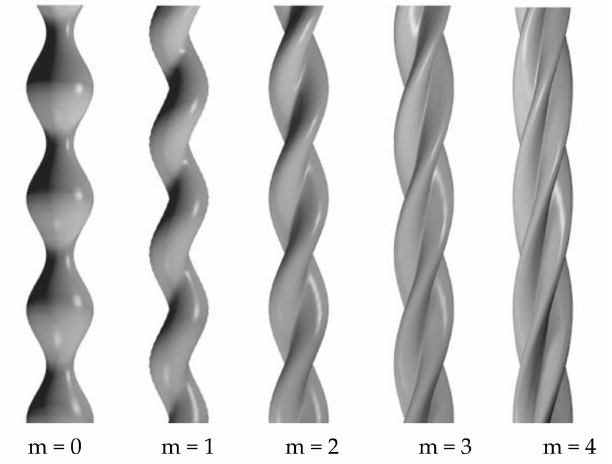
Figure 4. Schematic of various modes of disturbances on liquid jet